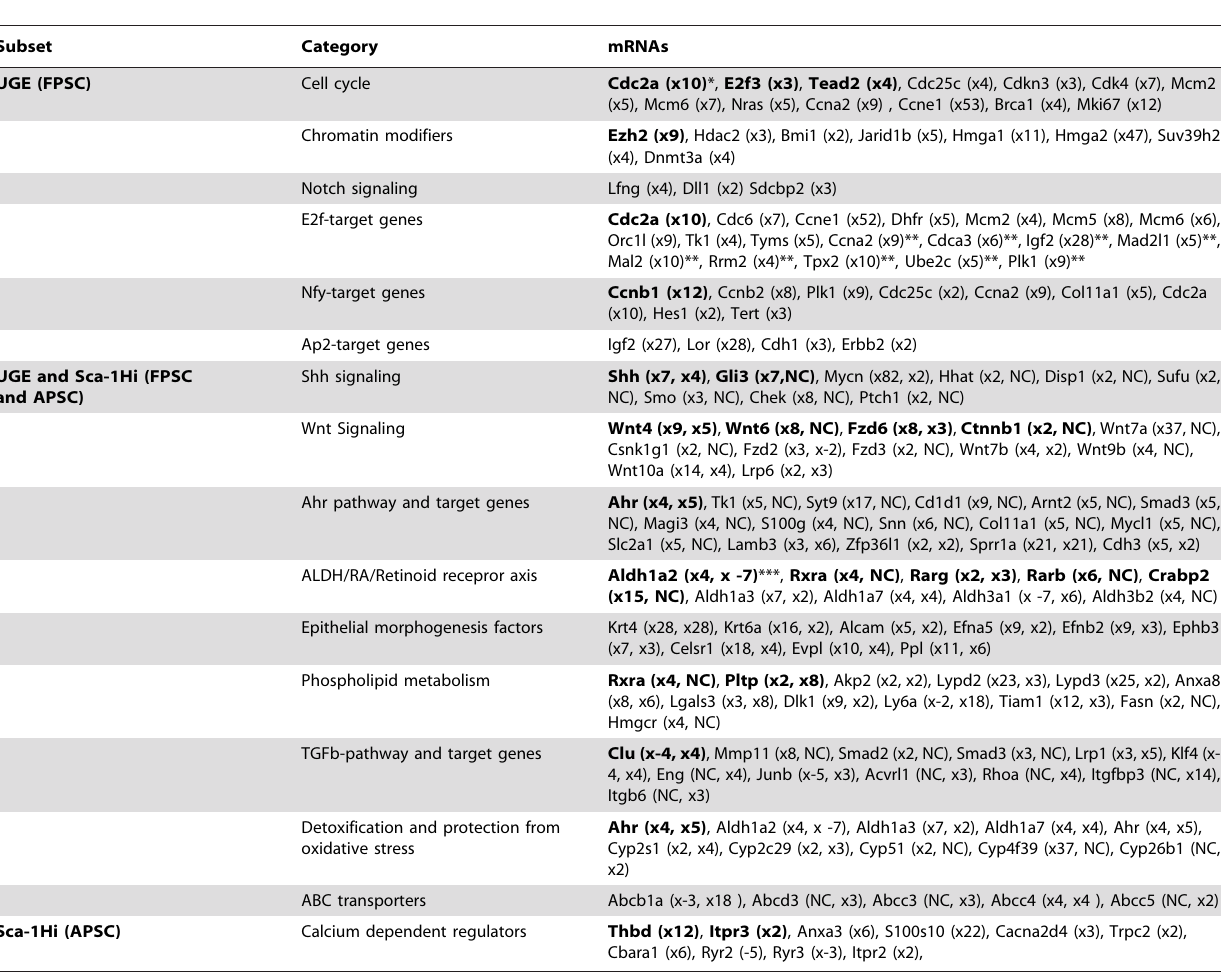
Functional classification is shown for 146 mRNAs scored as increased relative to differentiated Sca-1Neg cells (Table S3). The average relative increases (fold change) from three comparisons is given in parentheses. When two values are presented in brackets following a gene, the first number represents the fold change in UGE, the second in Sca-1Hi. A mRNA that is present but not increased is denoted NC. * Bolded genes represent those that were validated by FACS or